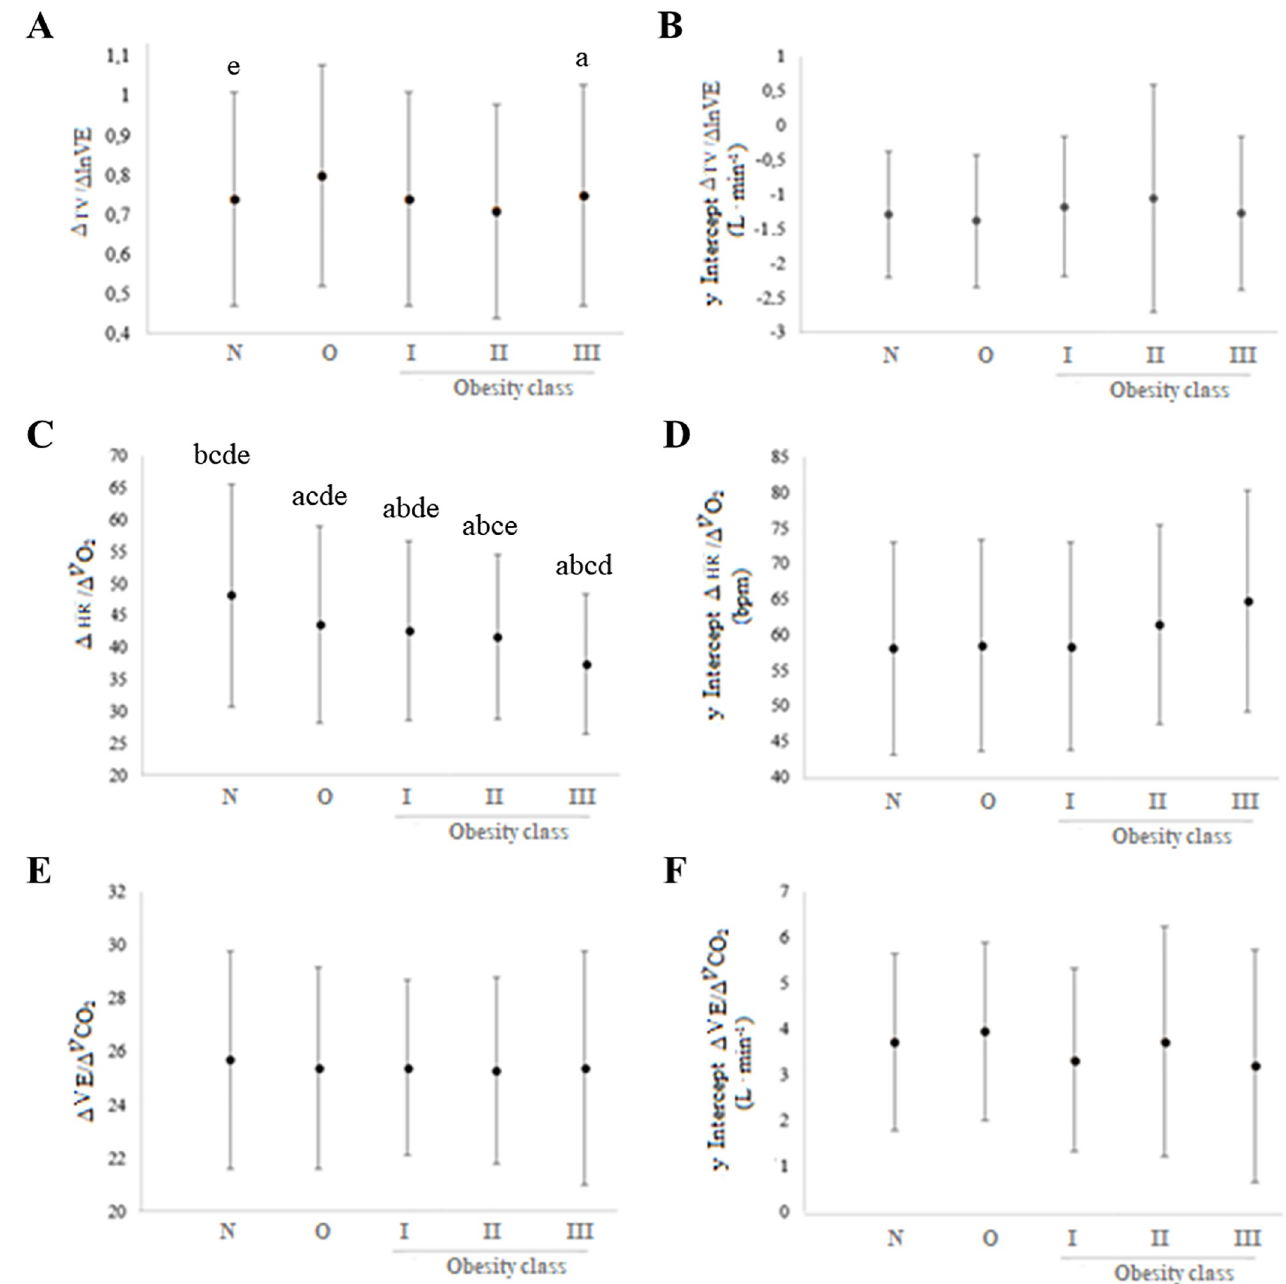
Fig 3. Differences in obesity-related physiological responses in the cardiopulmonary exercise test obtained by using multivariate analysis of variance (n = 1,594). a p � 0.05 vs. Normal weight; b : p � 0.05 vs. Overweight; c : p � 0.05 vs. Obesity Class I; d p � 0.05 vs. Obesity Class II; and e p � 0.05 vs. Obesity Class III. N: normal weight; O: overweight. (A) graphical representation of respiratory pattern; (B) graphical representation of y intercept of respiratory pattern; (C) graphical representation of cardiovascular efficiency; (D) graphical representation of y intercept of cardiovascular efficiency; (E) graphical representation of respiratory efficiency; (F) graphical representation of y intercept of respiratory efficiency. Models adjusted for age, sex, arterial hypertension, diabetes, : pulmonary oxygen uptake; _ V _ CO : carbon dioxide production; _ V _ E : minute ventilation; Vt: tidal dyslipidemia, and physical inactivity through self-report. _ V _ O 2 2 volume; Rf: respiratory frequency; HR: heart rate; bpm: beat per minute; ln _ V _ E : linearized ventilation; OUES: oxygen uptake efficiency slope.